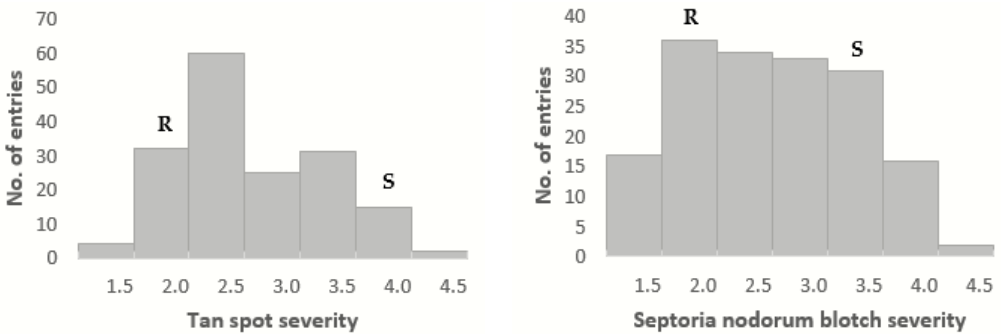
Figure 1. Histogram of best linear unbiased predictions (BLUPs) of 204 recombinant inbred lines (RILs) derived from the cross PBW343 (R-Parent) / KN (S-Parent) after inoculation with P. tritici-repentis isolate MexPtr1 and P. nodorum isolate MexSN4.